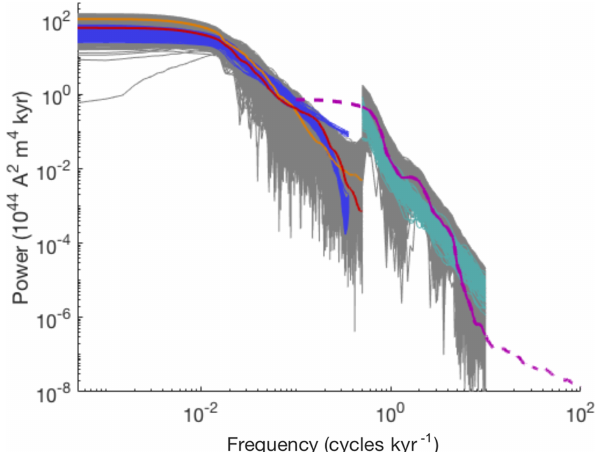
Figure 9. PSDs of data and model with parameters drawn from the posterior distribution of configuration (c). Orange: PSD of Sint- 2000. Red: PSD of PADM2M. Dashed purple: PSD of CALS10k.2. Solid purple: PSD of CALS10k.2 at frequencies we consider ( y hf ). Grey (low frequencies): 5 × 10 3 samples of the error model ε lf added to y lf . Grey (high frequencies): 5 × 10 3 samples of the error model ε hf added to y hf . Dark blue: PSDs of 100 posterior samples of the Myr model (with smoothing). Turquoise: PSDs of 100 posterior samples of the kyr model with uncorrelated